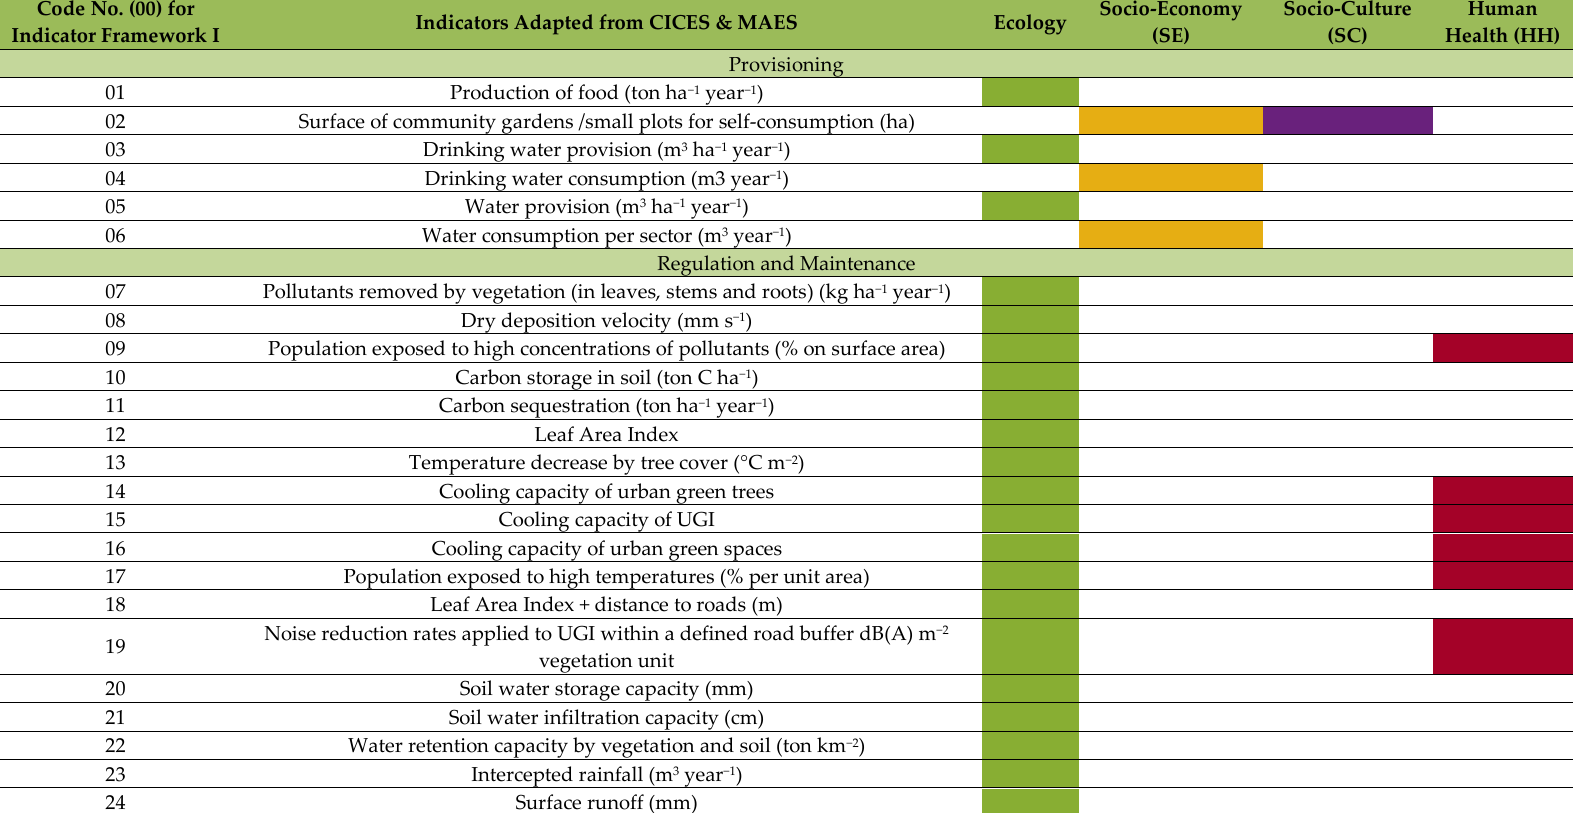
Table A1. Indicator framework I for Ecosystem Services (ESS) assessment from MAES classified in terms of four dimensions, i.e., ecological dimension (green color), socio-economic dimension (yellow color), socio-cultural dimension (purple color) and human health (red color) dimension. (Regarding the references for each indicator listed in the indicator framework I refer to the 4th report MAES [22] (pp. 71-81).) Code No. (00)